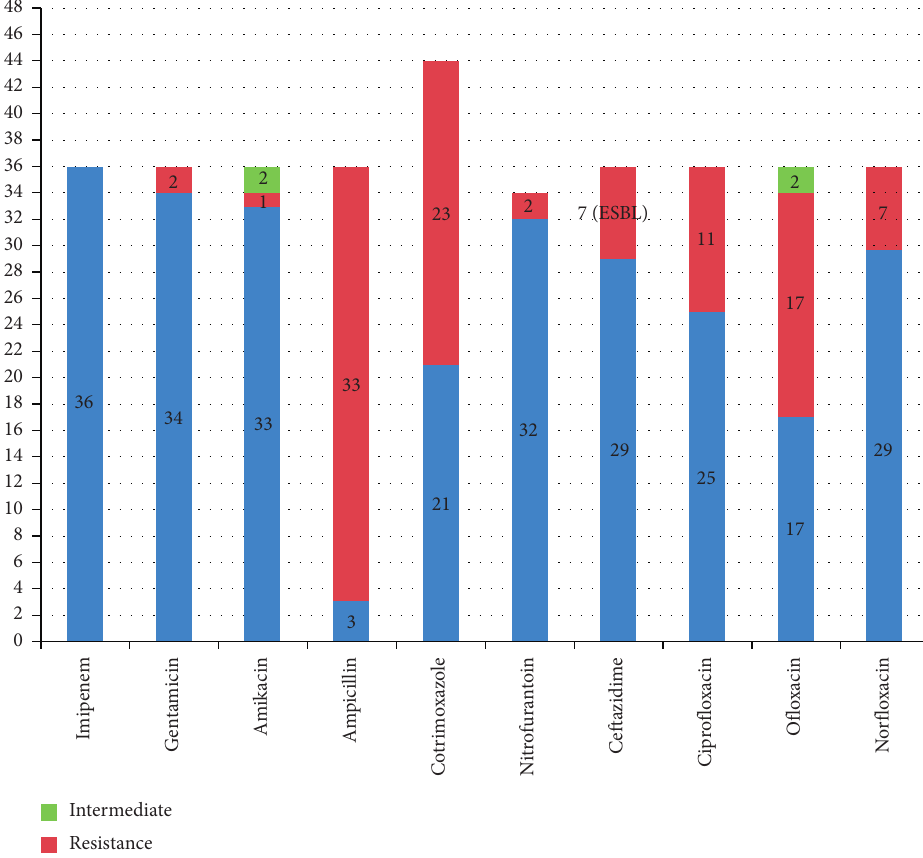
Figure 1: Antimicrobial susceptibility pattern of Gram-negative